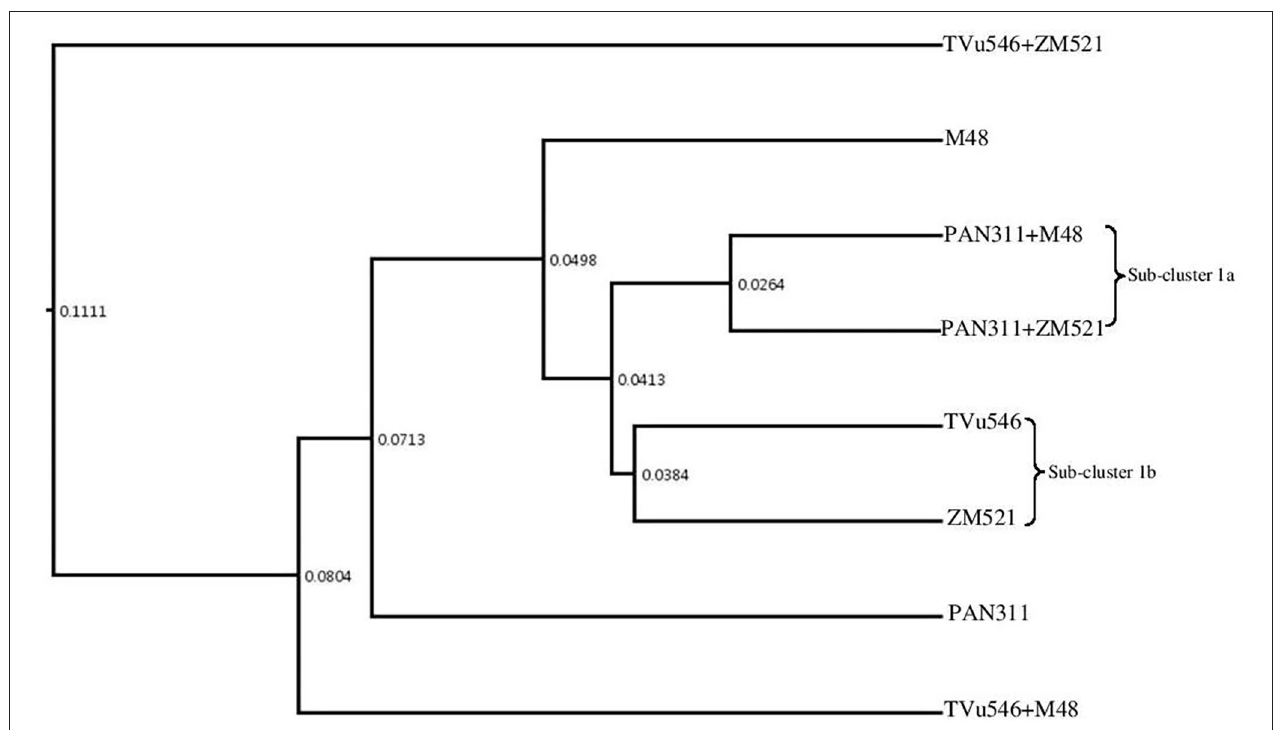
FIGURE 8 | Hierarchical cluster analysis based on distance matrix with the UPGMA algorithm for eight rhizosphere metagenomes of solo and intra-hole planted cowpea, sorghum, and